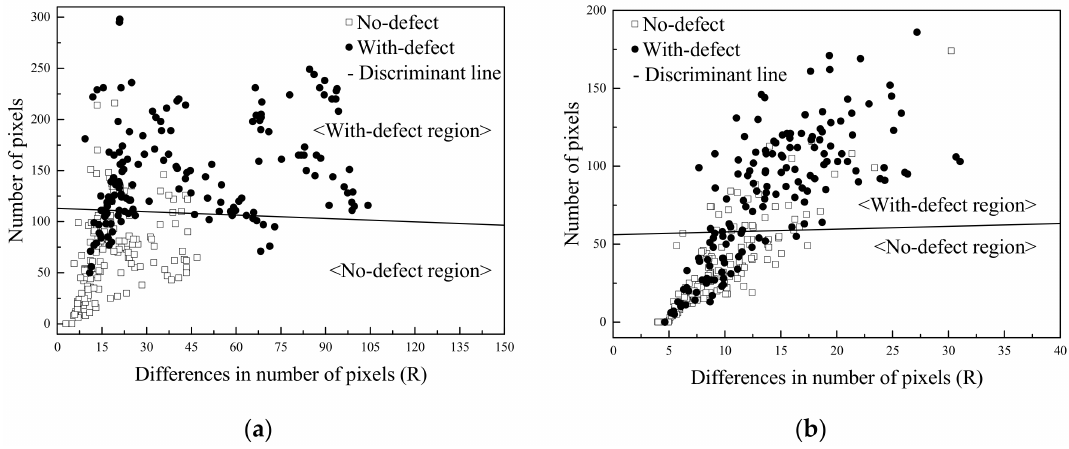
Figure 6. Results of LDA in ( a ) S0 and ( b ) A0